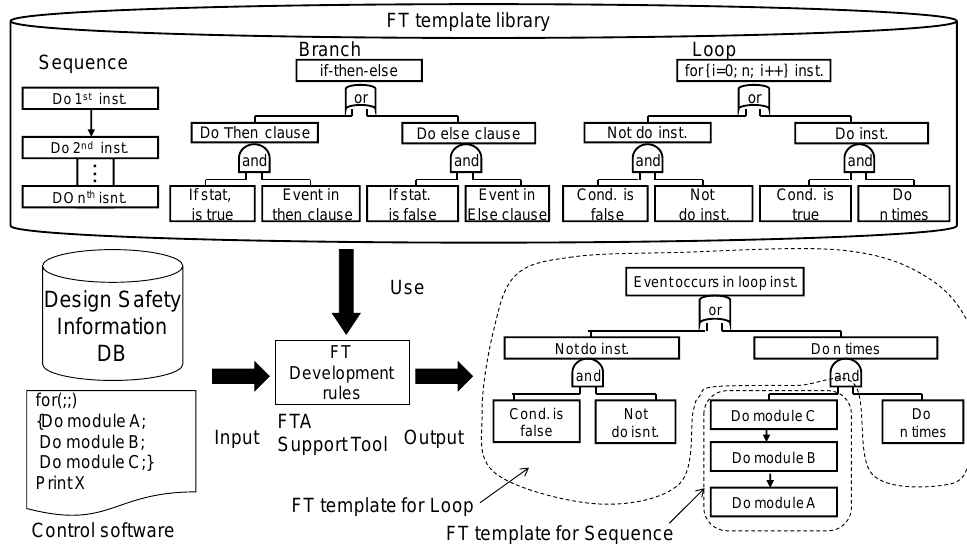
Figure 5. The procedure of the proposed fault tree analysis (FTA).